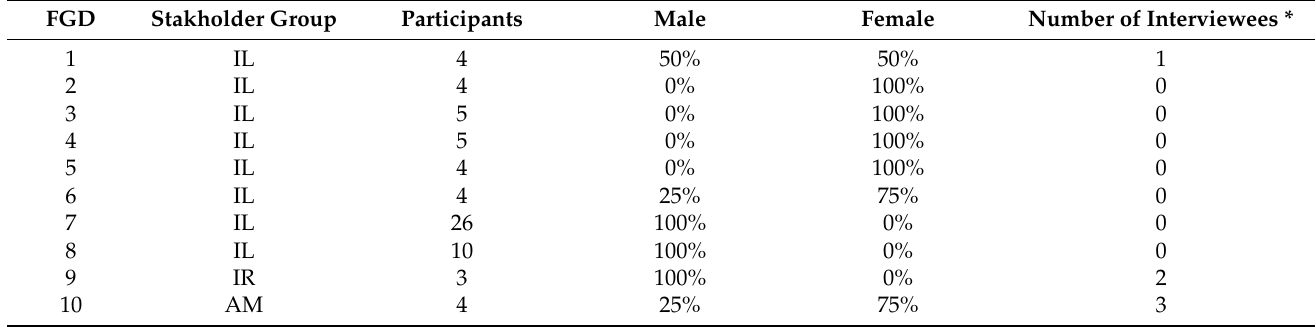
Table 1. Numbers, stakeholder groups and genders of participants involved in 10 focus group discussions (FGDs) consider- ing the issue of “too many dogs” in the remote Aboriginal community of Wurrumiyanga, Tiwi Islands. FGD Stakholder